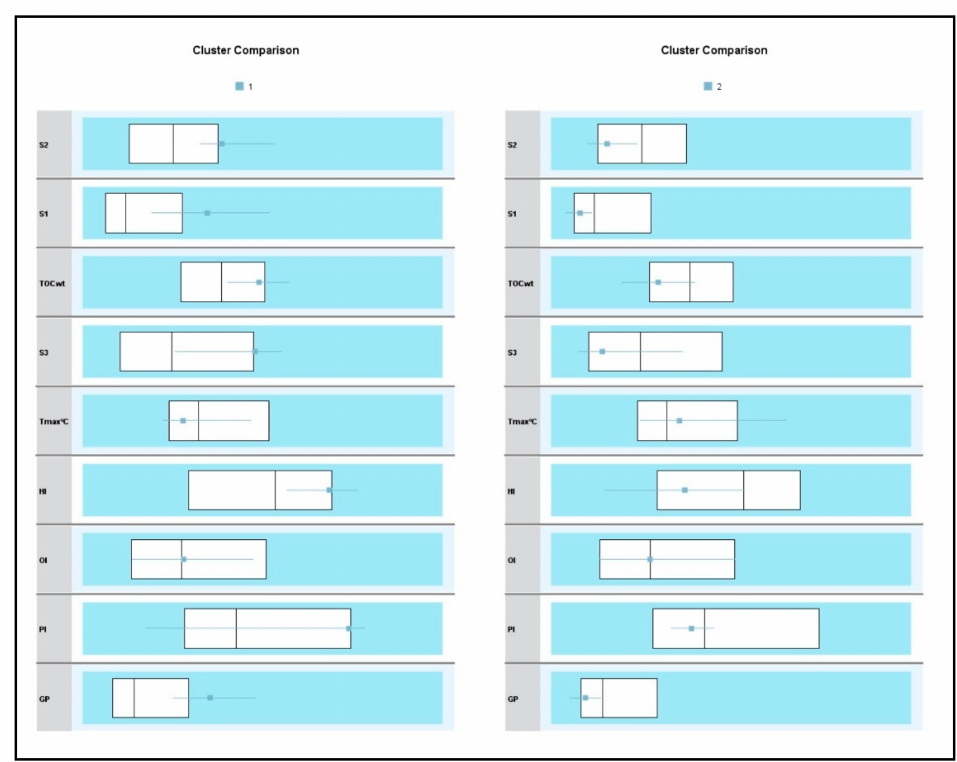
Figure 9. The two clusters resulting from the application of the TwoStep clustering